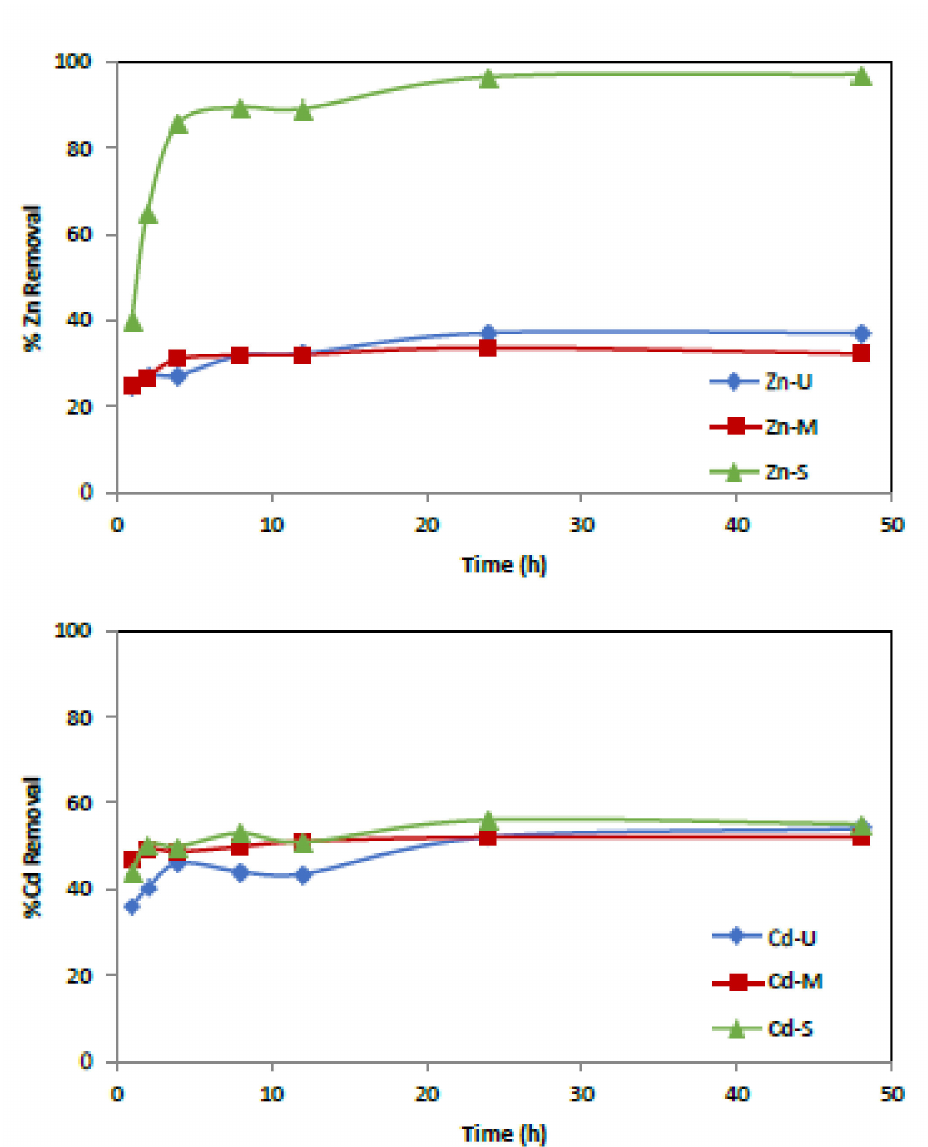
Figure 11. Effect of contact time versus % of metal adsorption. (Co = 50 mg/L, adsorbent = 0.25 g, t = 1–48